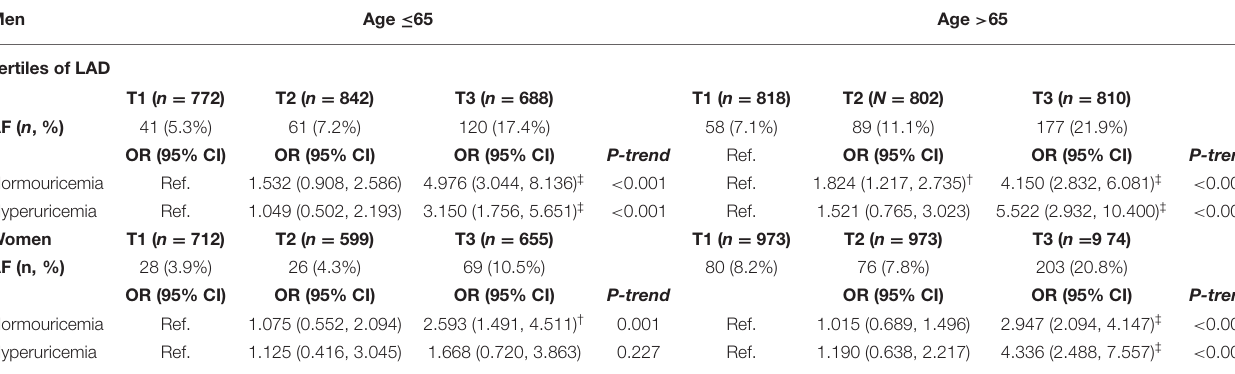
TABLE 5 | The impact of left atrium diameter in atrial fibrillation patients with normouricemia and hyperuricemia. Men Age ≤ 65 Age > 65 Tertiles of LAD